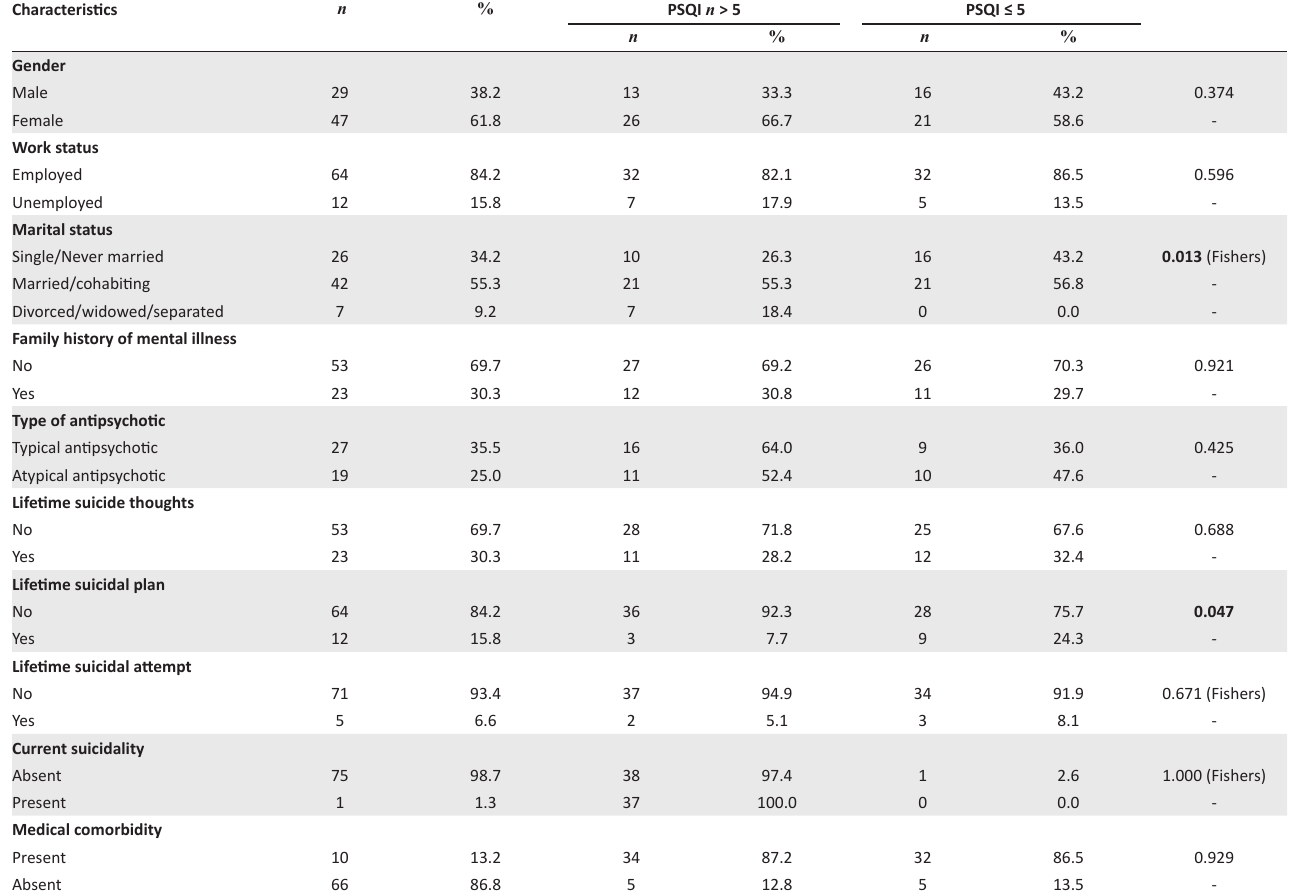
TABLE 1b: The sociodemographic and clinical characteristics of participants and comparison of clinical features of bipolar disease according to Pittsburgh Sleep Quality Index scores.